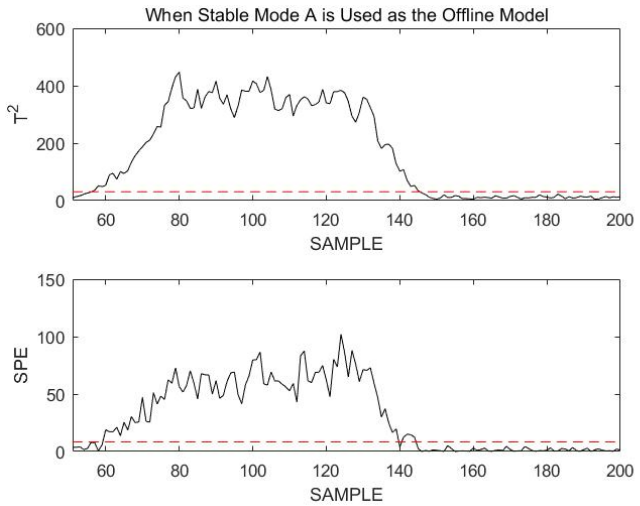
Figure 13. Monitoring 51st to 200th sample points using stable mode A as an offline model.